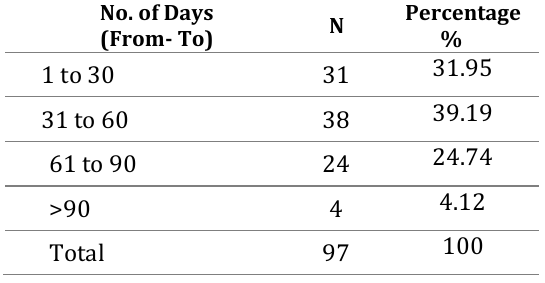
Table 1: Duration required to keep the chest tube till resolution of condition